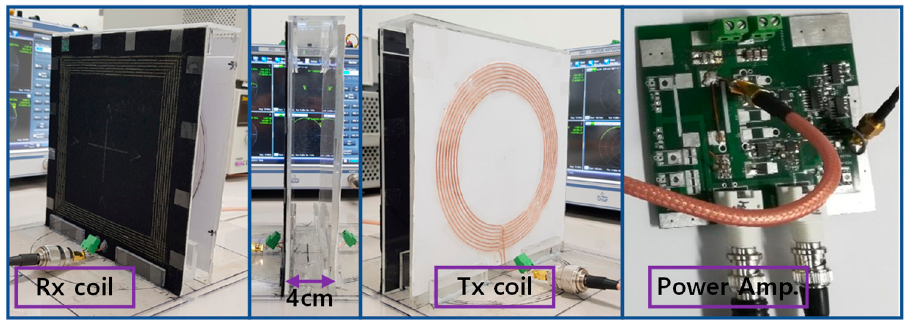
Figure 6. Experiment setup of optimized wire-wound Tx coil and conductive-thread textile Rx coil with power amplifier.